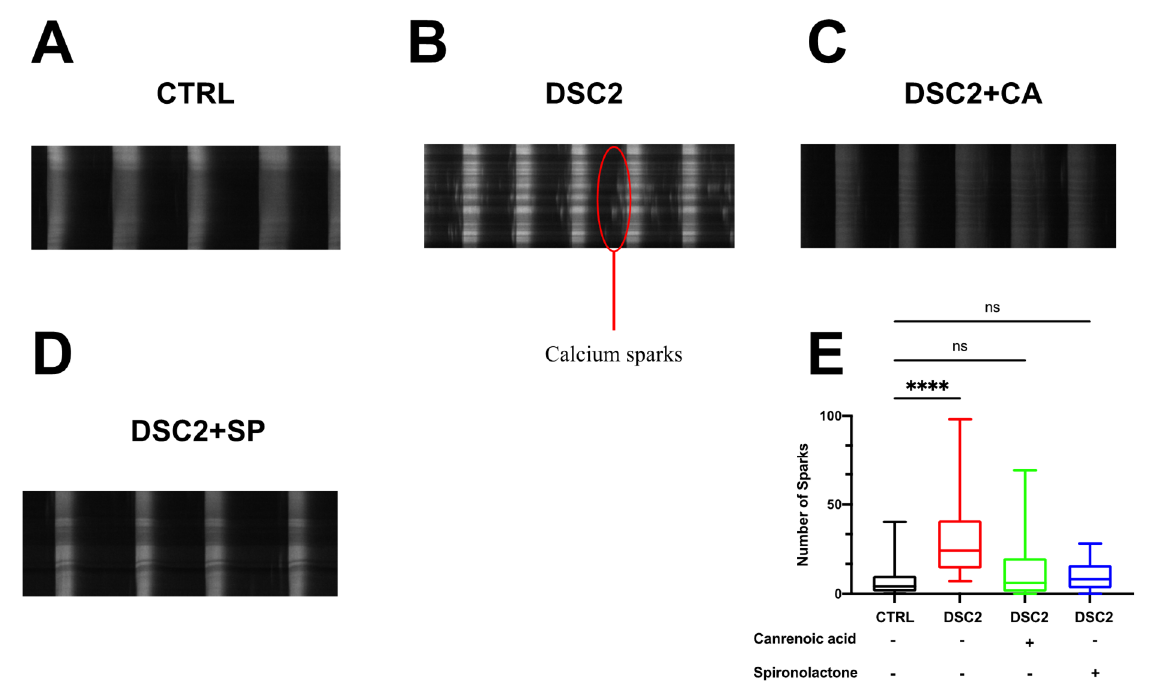
Figure 5. Effect of Canrenoic acid and Spironolactone on calcium sparks. Examples of spontaneous Ca 2+ transient recorded showing the presence of calcium sparks in control ( A ), DSC2 ( B ), DSC2 + CA ( C ), and DSC2 + SP ( D ). ( E ) Measure of number of sparks in each condition. Results are shown by boxplot with the median. The stars * correspond to the difference from the control. ns not statically significant, **** p < 0.0001 (Kruskal–Wallis test).